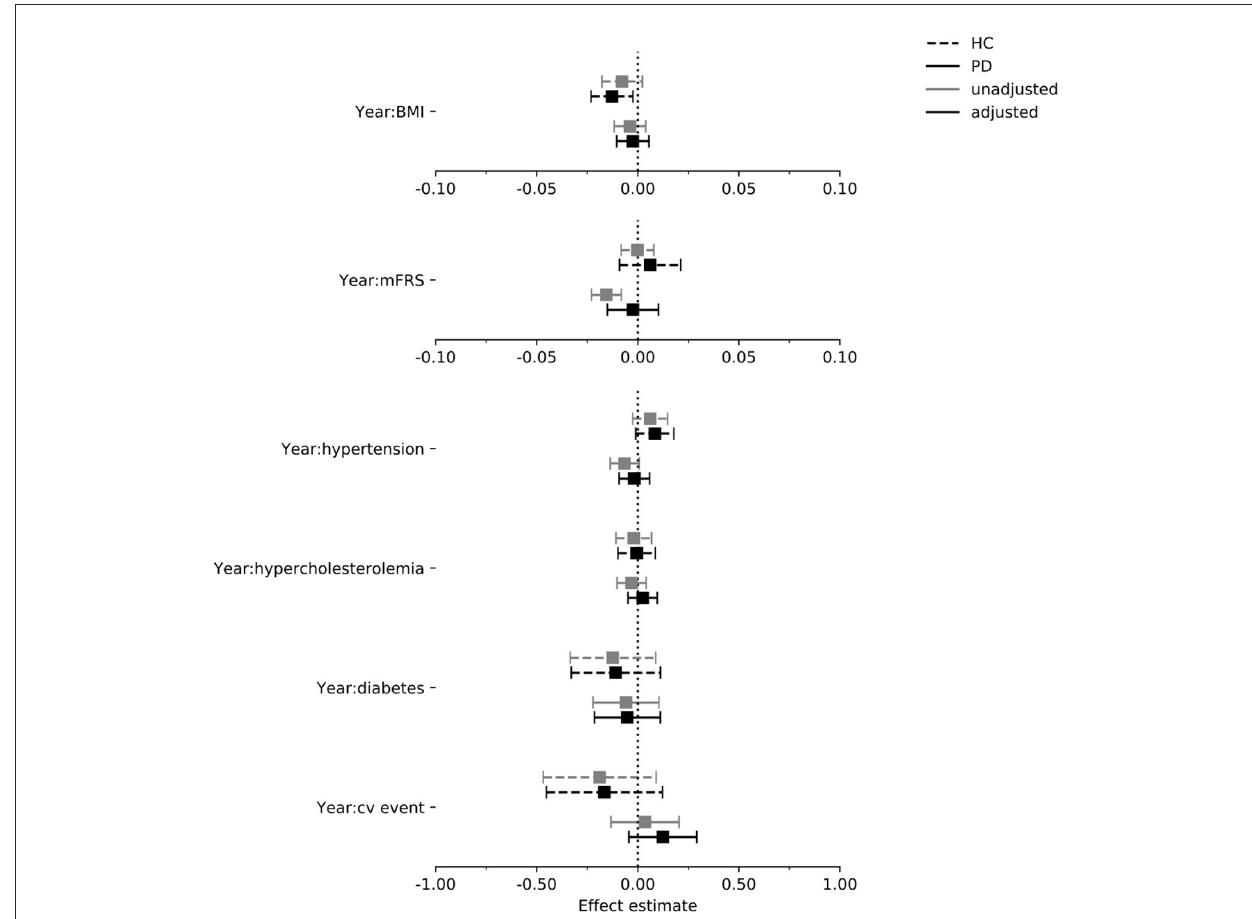
FIGURE6 Estimated effect of each exposure on the rate of change in the LNS score per year in the PPMI cohort. Intervals are 95% confidence intervals. mFrs, modified Framingham risk score; BMI, body mass index; cv, cardiovascular; HC, healthy control; PD, Parkinson’s